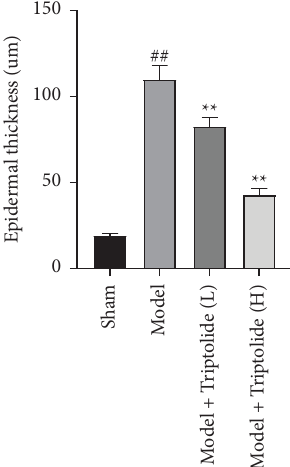
Figure 4: Triptolide mitigates psoriatic symptoms of psoriatic mice induced by IMQ. BALB/ c mice in the sham group were painted with vaseline daily. Mice in the model group and triptolide-treated groups were painted with IMQ daily. Te triptolide groups were applied simultaneously with IMQ and triptolide (10 or 40mg/kg). Skin lesion analysis was performed following sacrifcing these mice. (a) Back skin photos of mouse models in the sham group, model group, model+triptolide (L) group, and model+triptolide (H) group taken on the 8th day after IMQ painting. (b) PASI scores of mouse models in each group evaluated daily. (c) Te H&E-stained dorsal skin of mouse models in the indicated groups after IMQ treatment for 8 days. (d) Evaluation of epidermal thickness under a microscope via ImagePro Plus software. Each column is representative of data obtained from a minimum of 8 animals. ## P < 0 . 01 compared to the sham group; ∗∗ P < 0 . 01, ∗∗∗ P < 0 . 001 compared to the model